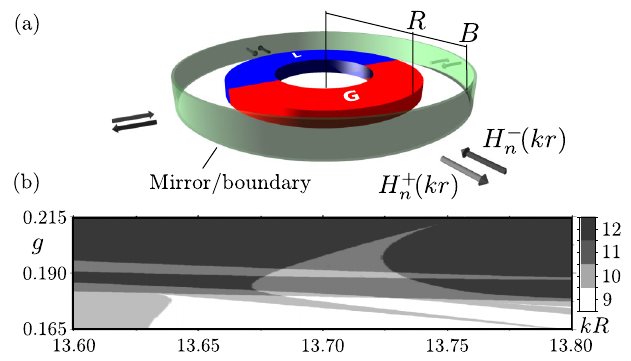
FIG. 4. (a) PT -symmetric disk of radius R consisting of one region with loss (blue) and one with gain (red), enclosing an air gap ( n 0 ¼ 1 throughout). As in 1D, a partially transparent mirror (green region) can be used to vary the coupling strength to the asymptotic region. (b) A small part of the complicated phase diagram with overlapping phases of broken and unbroken PT symmetry for the S -matrix eigenstates in this system. Different shades of gray correspond to different numbers of pairs of scattering-matrix eigenvalues in their respective PT -broken phases. As we verified explicitly with our numerical simulations for this device, the phase diagram stays unchanged when tuning the reflectivity of the mirror placed in the far field. (We choose a value B ¼ 1000 (cid:10) R